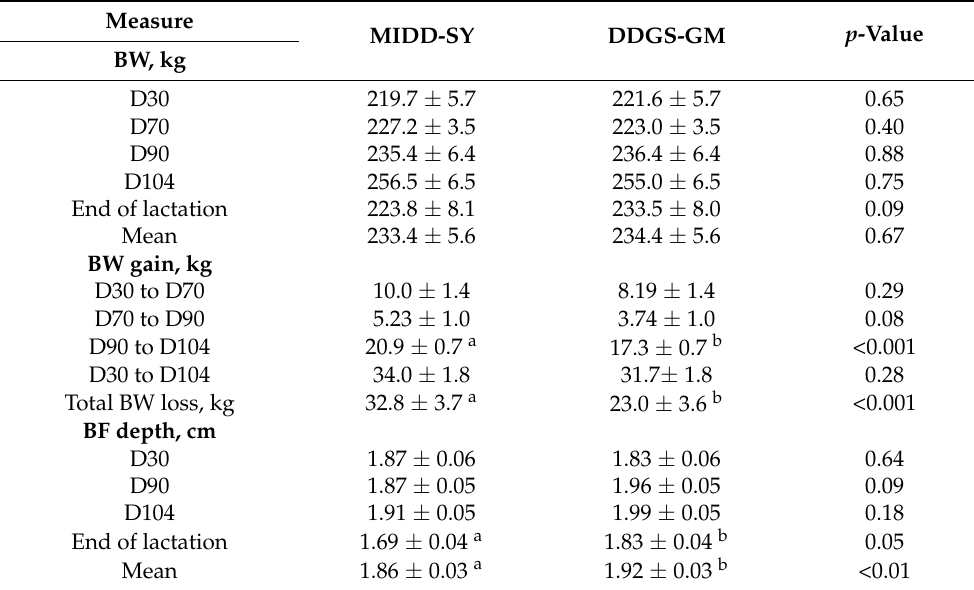
Table 6. Main effects of fibrous diet source on mean body weight, gain, and loss, backfat depth for gestating sows kept in group pens (9 sows/pen) 1